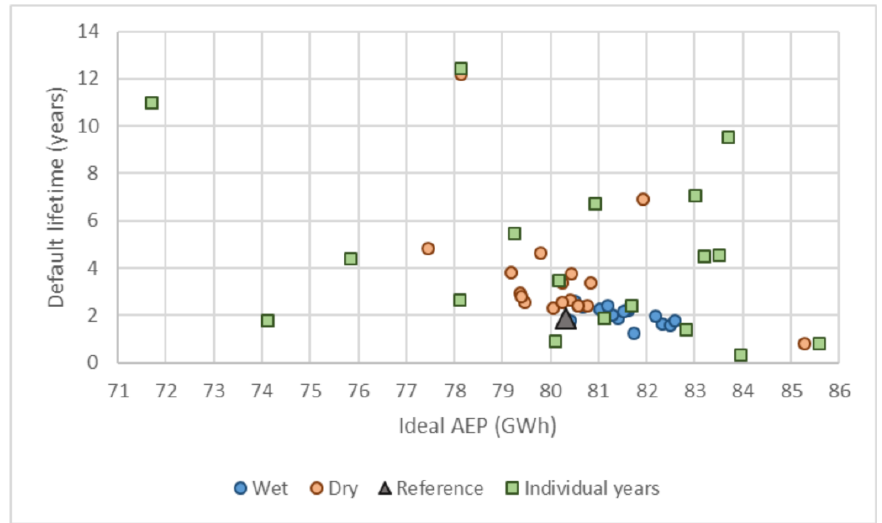
Figure 13. Default lifetime vs. ideal AEP for ± 2 standard deviations on rain rate for 17 samples sizes and for the reference of 18 years for Hvide Sande and for each of the 18 individual years from 2002–2019.